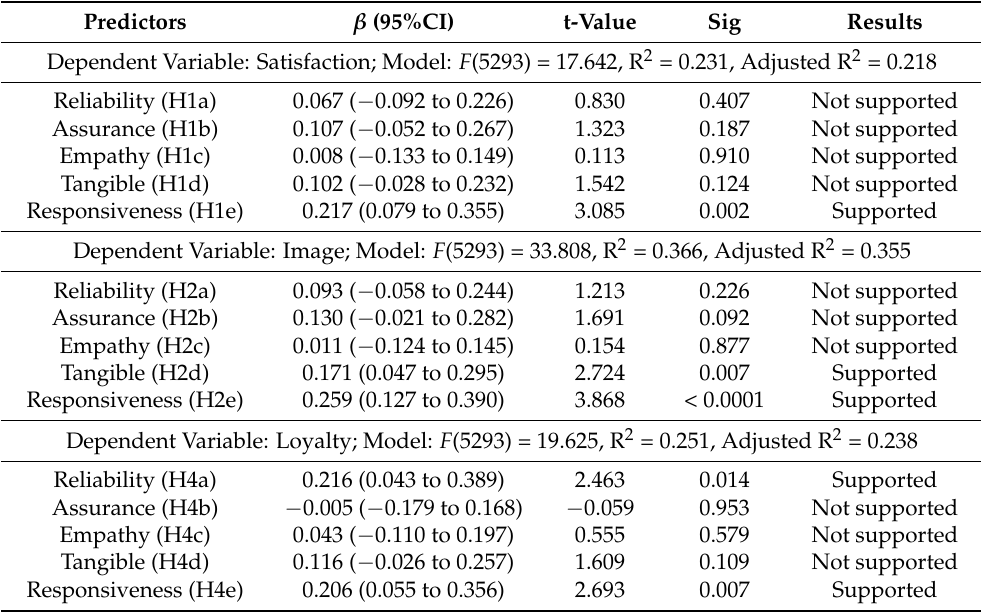
Table 5. The results of linear regression models to assess the impact of five service quality constructs on customer satisfaction and loyalty as well as the airline